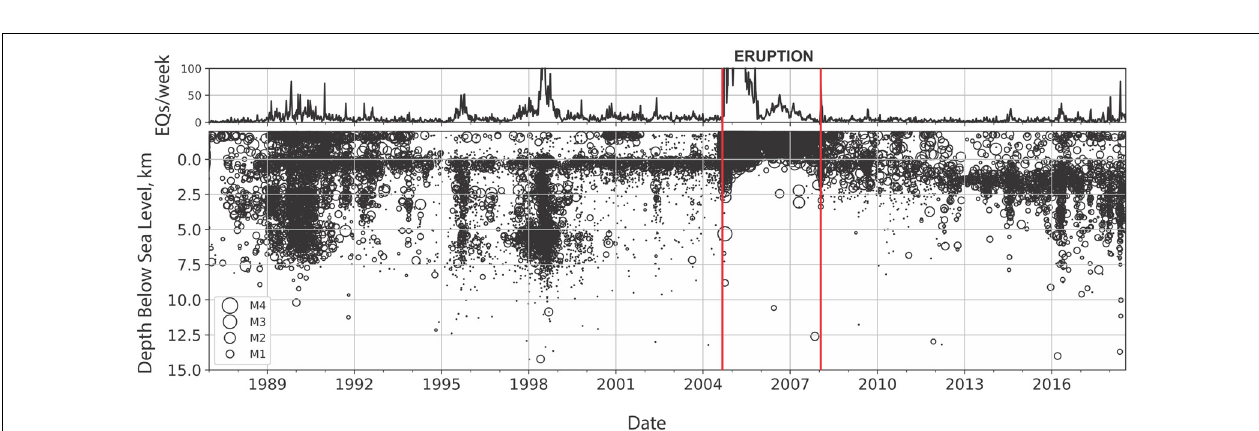
FIGURE 3 | Weekly rate (top) and depth versus time plot (bottom) for earthquakes at Mount St. Helens, 1987–July 2018. Earthquakes used in this plot are from the Pacific Northwest Seismic Network (PNSN) catalog in a box bounded by 46.15 N and 46.25 N latitude, and by 122.25 W and 122.15 W longitude. All earthquakes are plotted regardless of the quality of the location. Depths are relative to sea level; surface elevations in the area are mostly 1–2 km above sea level.